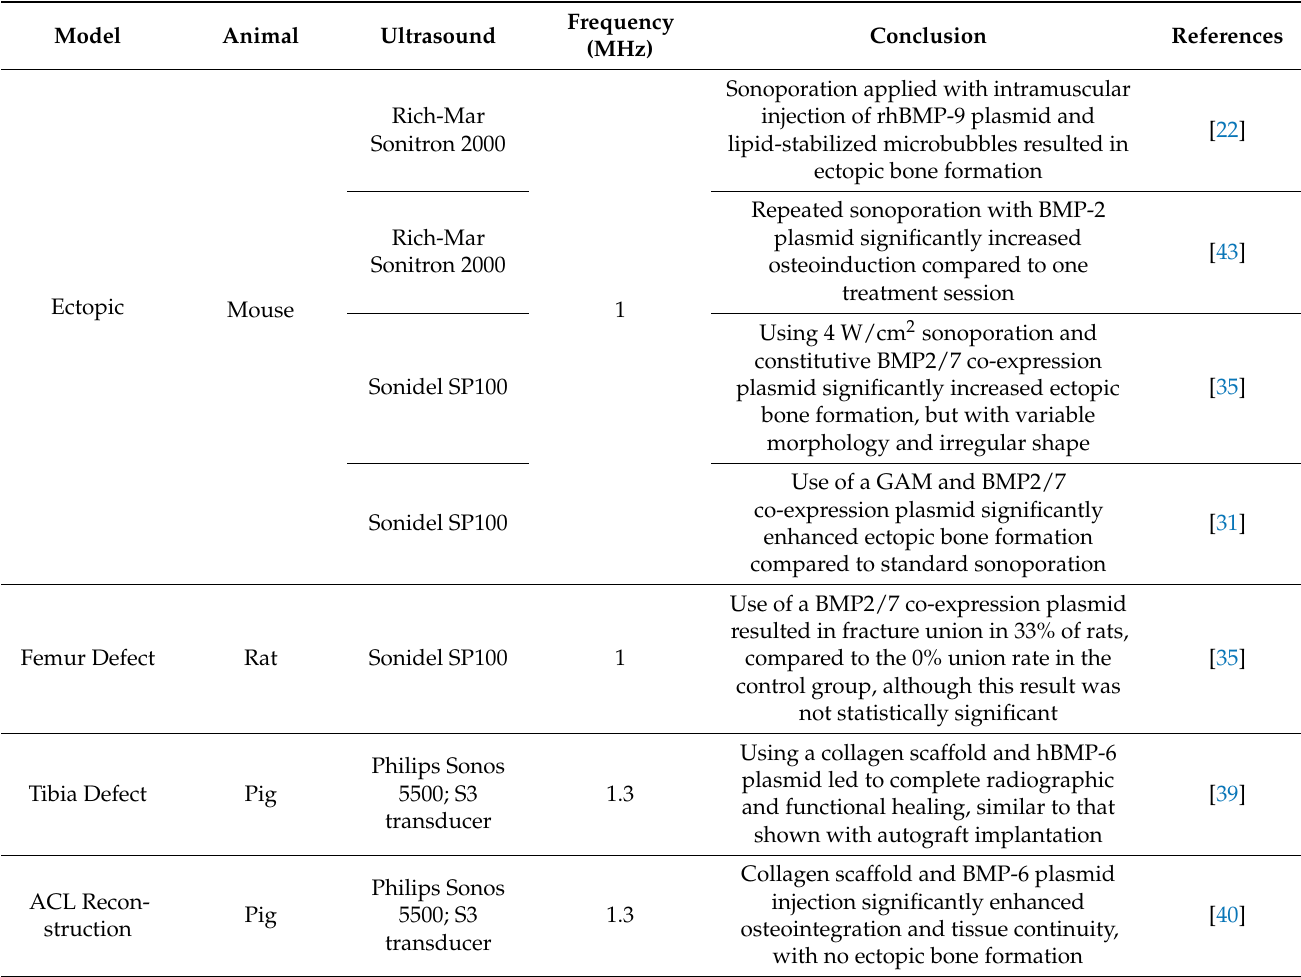
Table 3. The use of sonoporation for skeletal tissue